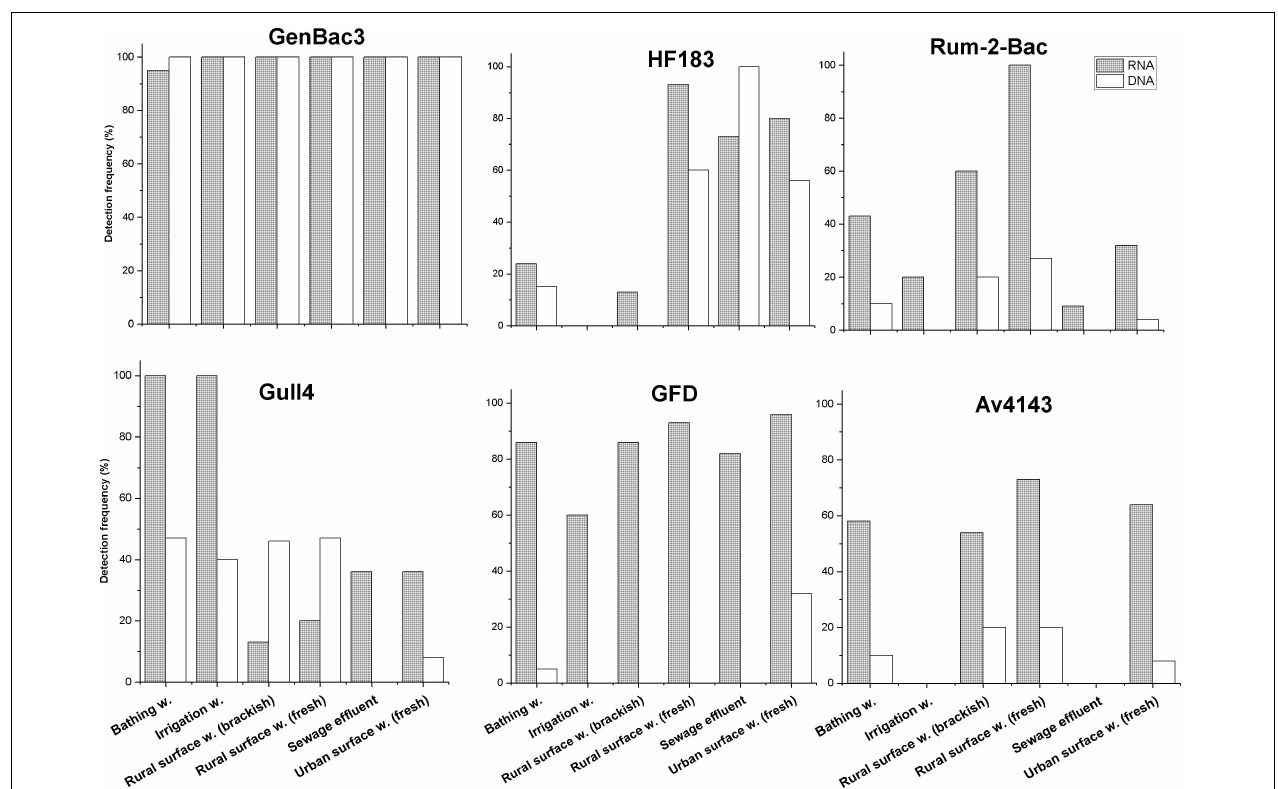
FIGURE 6 | Detection frequency (%) of the MST markers in the groups of surface water samples with both RNA-based and DNA-based approaches. Only markers with detection frequency > 20% in surface water groups are shown. In x -axis: sample group. W,